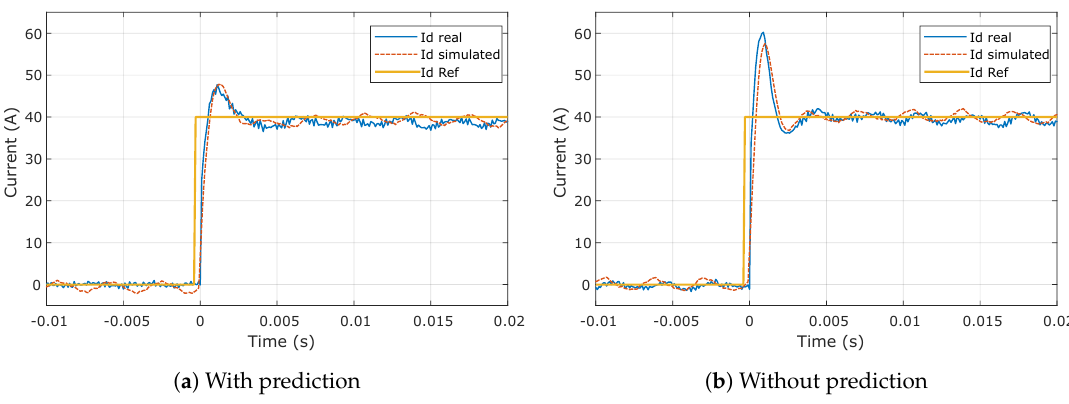
Figure 13. Experimental and simulation results for a system with delay of two samples. Additionally, in Figure 14a,b, we show, respectively, the reactive and the grid currents when the controller commands a negative current step in a system with a delay of three samples (two from the network and one from the digital control) and that uses the model-based predictor. Note that we do not consider this a real use-case of the proposed method because the designers have the freedom to choose the sampling period and the communication network deployed; we believe that it is better to have a higher sampling period than a loop delay higher than two samples. Despite this consideration, the system response has the same settling time and overshoot as when the network adds a single delay, but without the prediction, the system becames unstable.